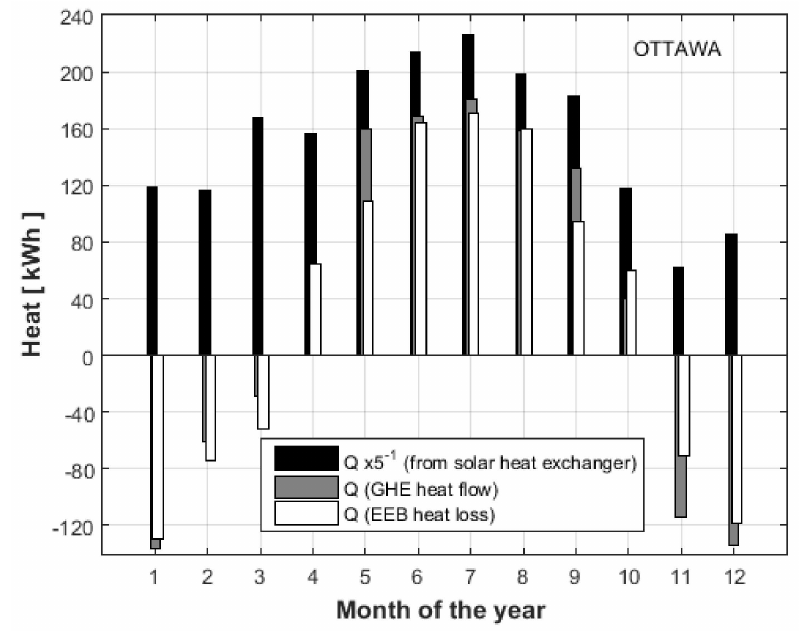
Figure 12. Monthly heat flow across the EEB for Ottawa, for the scenario of 12 PVTs paired with 12 BHEs and for the 6th year of